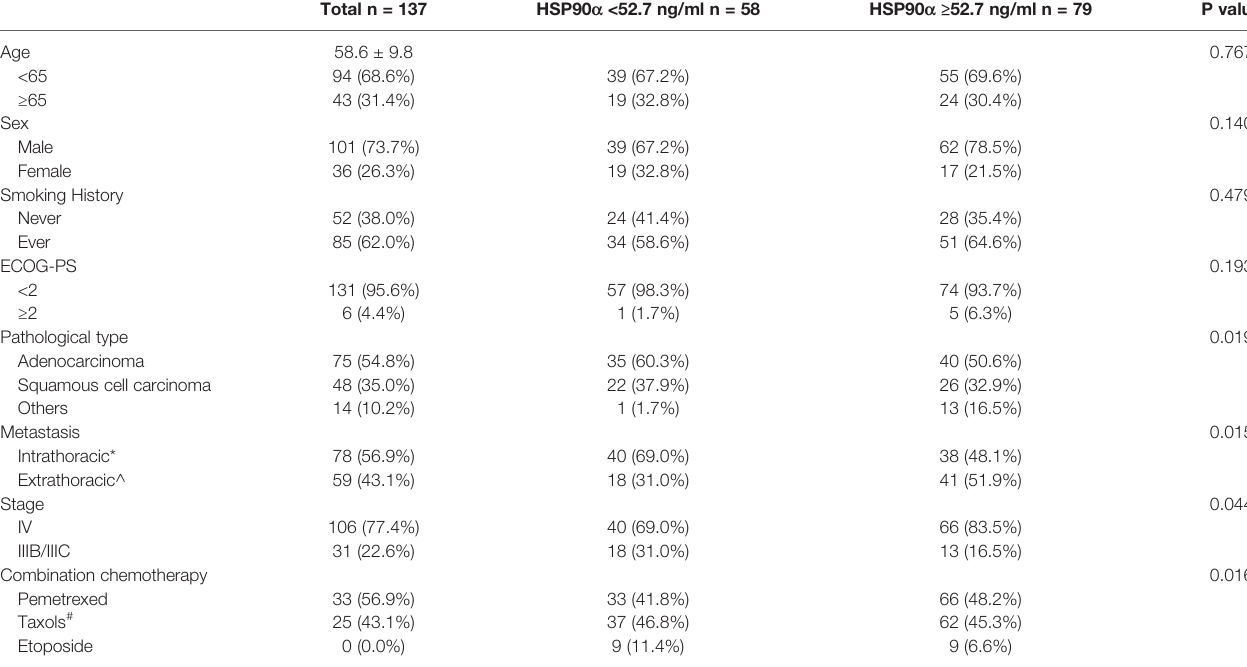
TABLE 1 | Baseline clinicopathological features. Total n = 137 HSP90 a <52.7 ng/ml n =